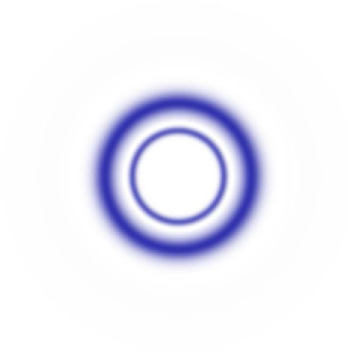
Fig. 9 The planar section of the energy density passing through the center of the structure for n = 2 and α = 0 . 3